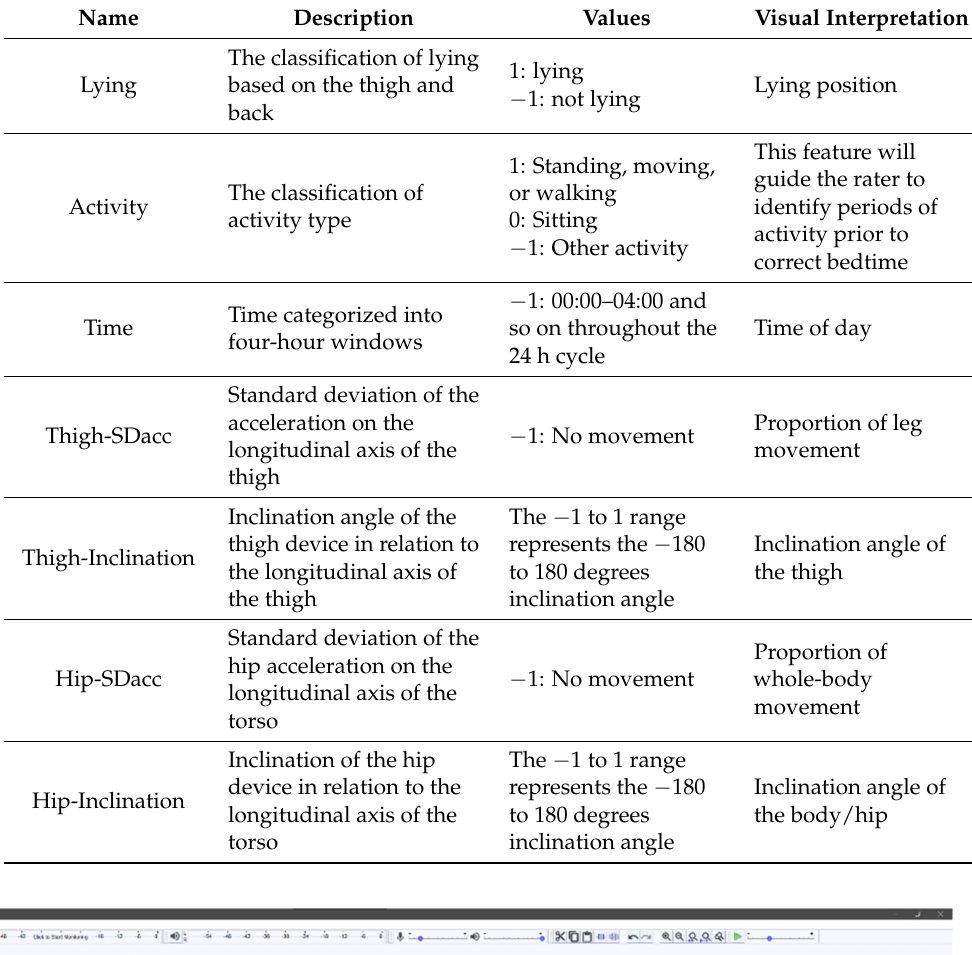
Table 1. Signal features for the detection of in-bed periods in Audacity.